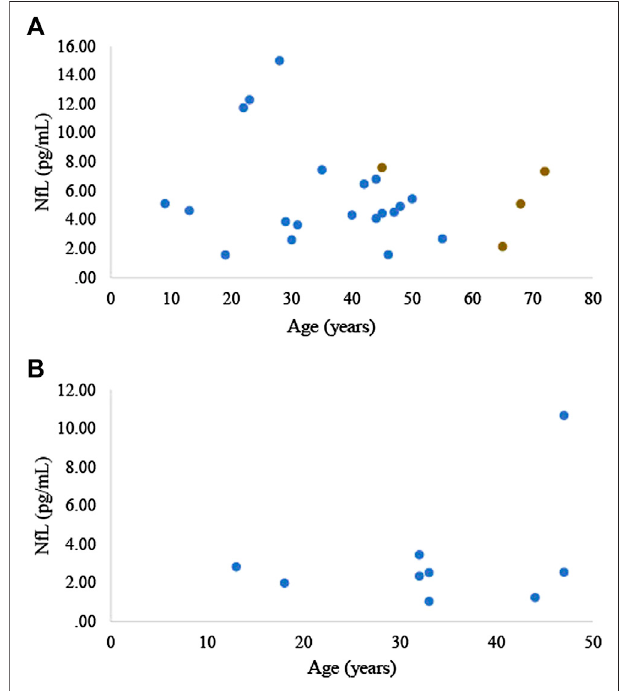
FIGURE 2 | (A) Serum and (B) plasma NfL concentrations in zoo Asian elephants ( Elephas maximus , n (cid:2) 21; n (cid:2) 9, respectively). The four brown data points represent samples collected from the same